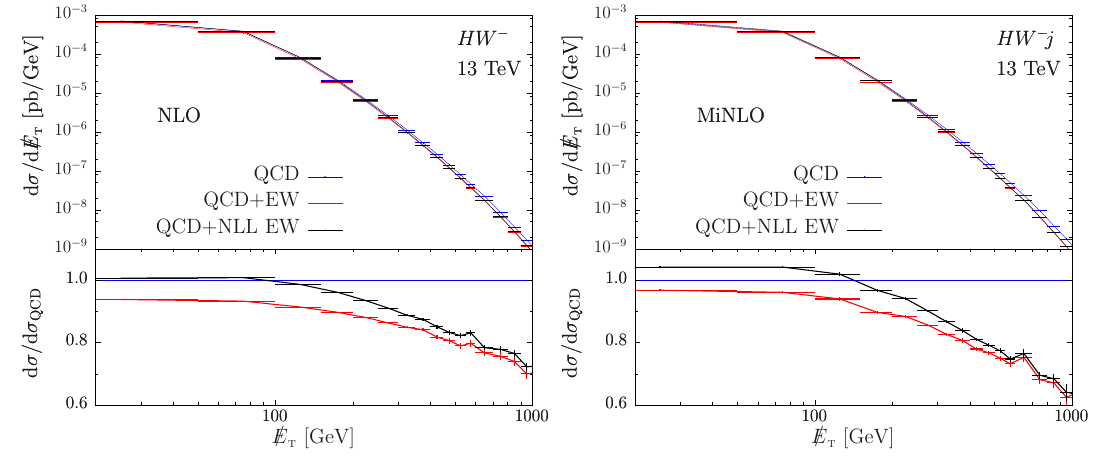
Figure 5. NLO predictions for the missing transverse momentum in HW (cid:0) (left) and HW (cid:0) j (right) production. Predictions and labels as in (cid:12)gure